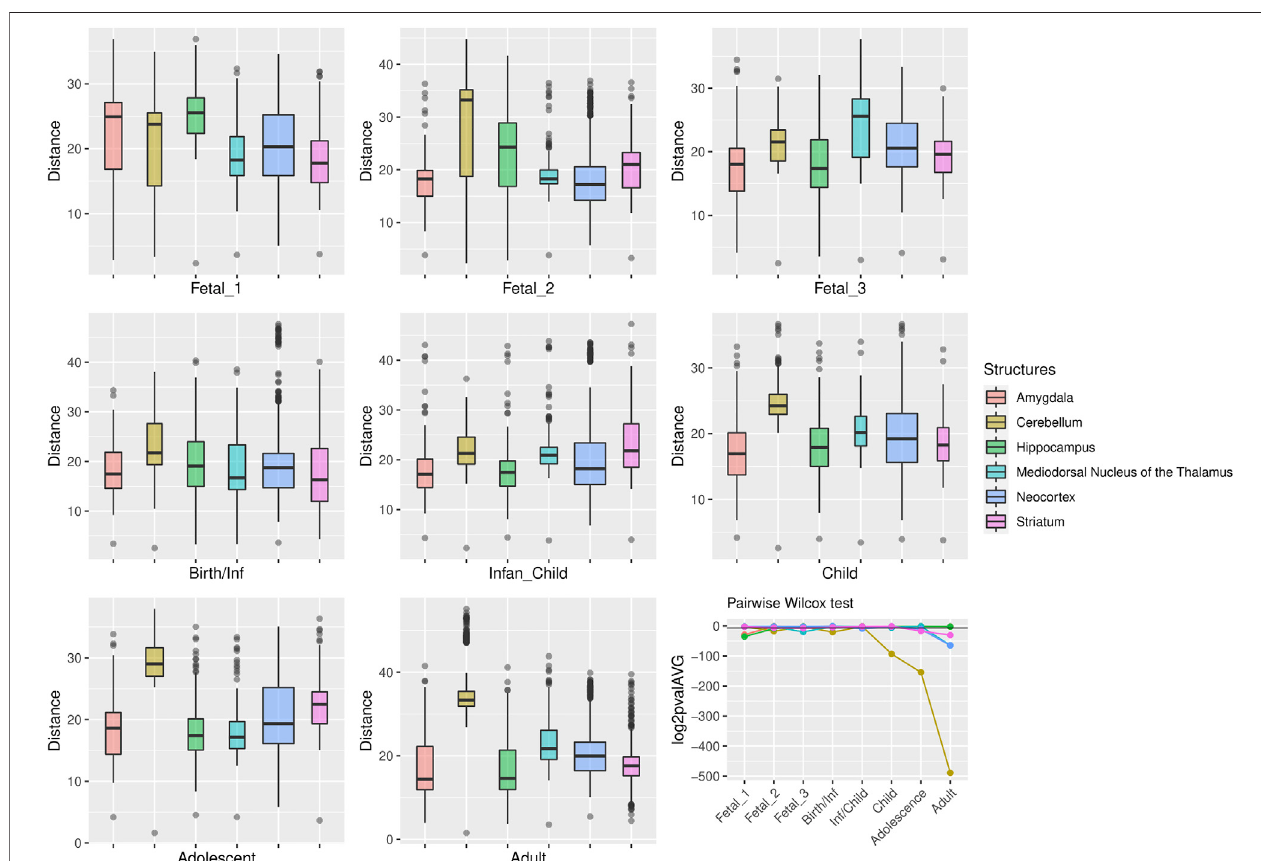
FIGURE 4 | Genes within large deserts. One structure, the cerebellum, reports the most signi fi cant differences (pairwise Wilcoxon test with Bonferroni correction) encompassing postnatal stages: childhood ( p = 1.06 × 10 − 28 ), adolescence ( p = 4.71 × 10 − 47 ), adulthood ( p = 5.54 × 10 − 148 ); also at birth ( p = 5.64 × 10 − 7 ) and fetal stage2( p =4,79×10 − 6 ).Signi fi cantdifferencesarealsofoundforthethalamus(fetalstage3andadulthood),thehippocampus(fetalstages1and2)orthestriatum(fetal stage3,adolescenceandadulthood).TheboxplotsshowthevaluesofthepairwiseEuclideandistancesateachstageforeachstructure.Thelinegraphrepresents the average p -value (log2-transformed for representational purposes) foreach pairwisecomparison betweenstructuresat each stage. The horizontal blacklinedenotes p =